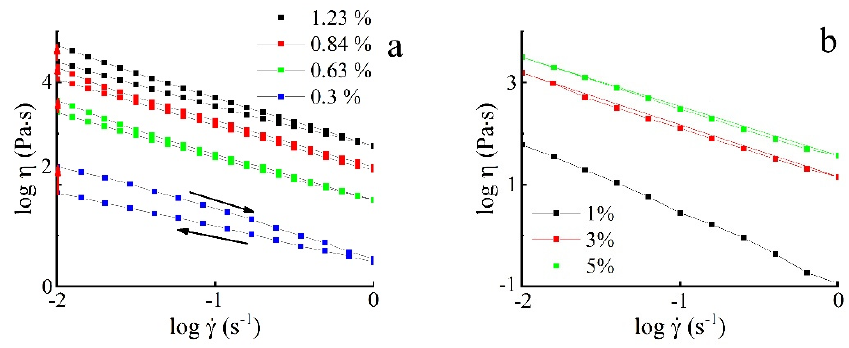
Figure 6. Flow curves of BC aqueous suspensions ( a ) and NCC suspensions ( b ). The polymer phase content indicated in figures.